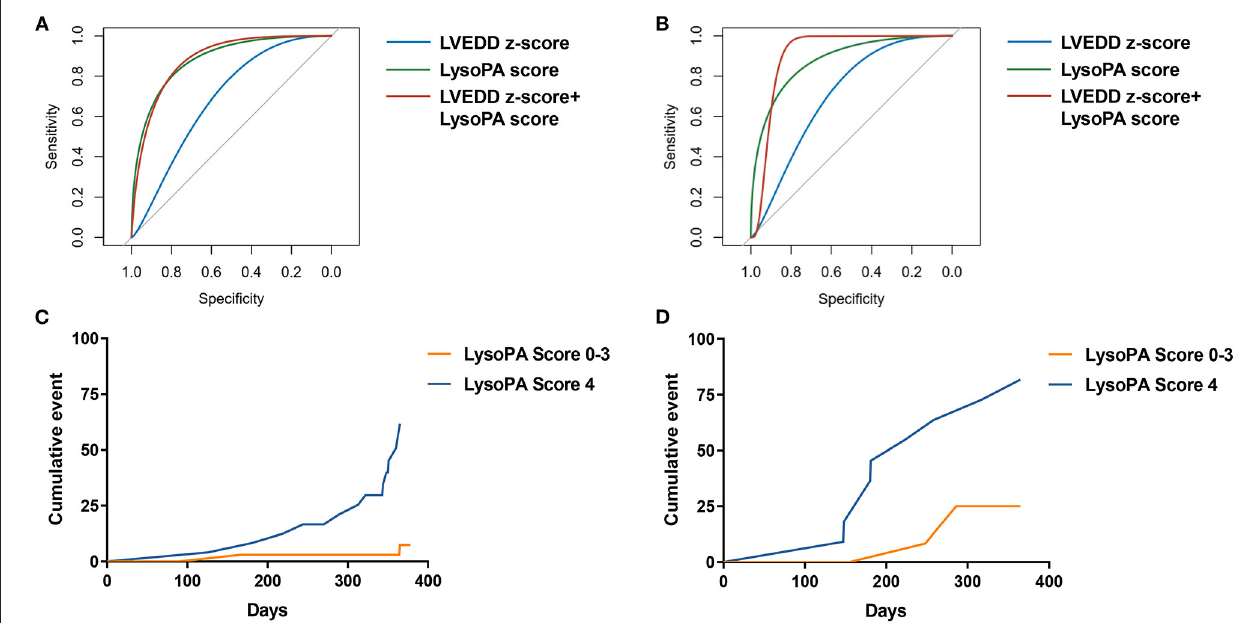
FIGURE 2 | The prediction of LysoPA score for LVRR. ROC curves for predicting LVRR in (A) discovery set and (B) validation set. Kaplan–Meier cumulative event curve of LysoPA score for predicting LVRR in (C) the discovery set and (D) validation set.